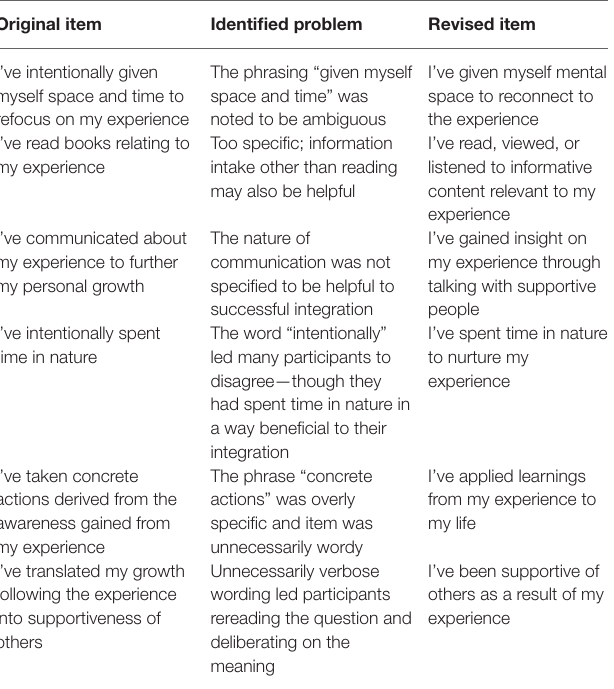
TABLE 1 | Item revisions to IES scale items based on cognitive interviewing feedback.